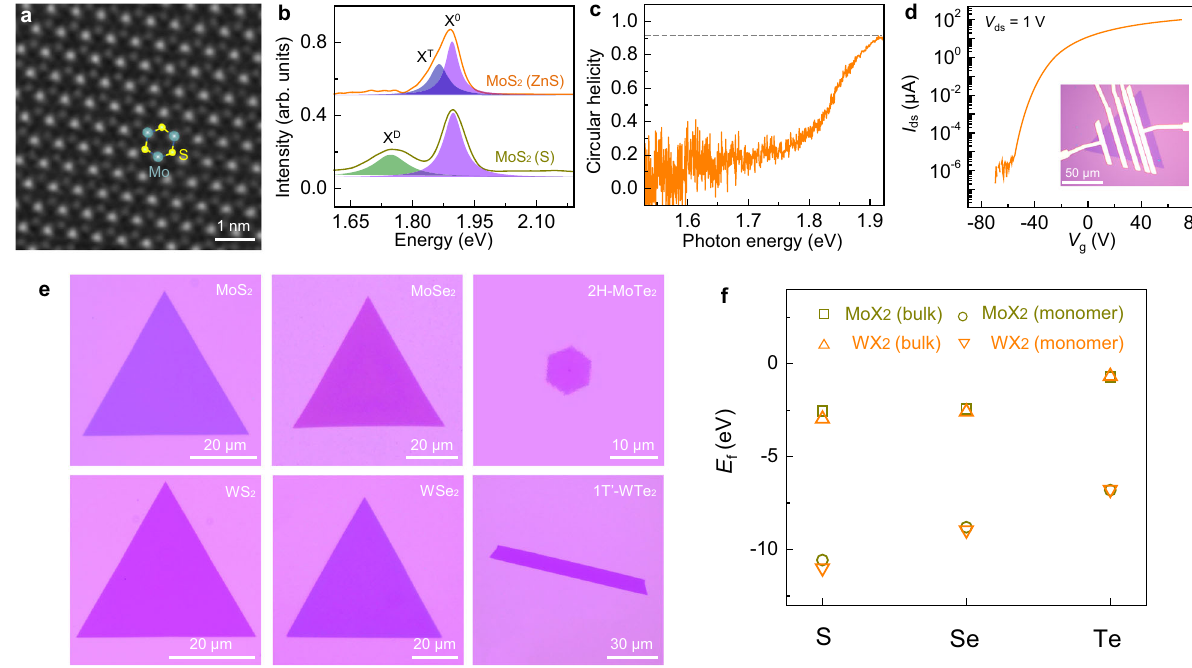
Fig. 2 Quality characterizations of the as-grown MoS 2 domain and universal growth of diverse TMDs by chalcogen monomer supply. a Atomic- resolved HAADF-STEM image of the prepared MoS 2 , revealing the high crystallinity of MoS 2 without detectable S vacancies. b Low-temperature (10 K) PL spectra of MoS 2 samples fed by S monomer (orange curve) and S powder (dark yellow curve), respectively. Three typical features, X 0 , X T , and X D peaks assign to neutral exciton, trion, and defect state emission peaks, respectively. The absence of X D peak con fi rmed the high quality of the MoS 2 grown by S monomer supply. c The circular dichroism PL spectrum measured at 10 K. The near-unity polarization of MoS 2 on sapphire indicates the high optical quality. The horizontal dashed line is added for clarity. d Transfer characteristic of the MoS 2 FET with channel length and width of 7 μ m and 22 μ m, respectively, at a bias voltage V ds of 1 V. Inset: optical image of the device. e Optical images of the representative TMDs, including 2H phase MoS 2 , MoSe 2 , MoTe 2 , WS 2 , WSe 2 and 1T ′ phase WTe 2 . f The calculated formation energy ( E f ) of the six representative TMDs. When chalcogen bulks are supplied as precursors, the formation of transition metal tellurides in relative to their corresponding sul fi de and selenide are less favourable due to their high formation energies ( − 0.73 and − 0.68 eV/unit for MoTe 2 and WTe 2 , respectively). While it becomes highly favourable when Te monomers are